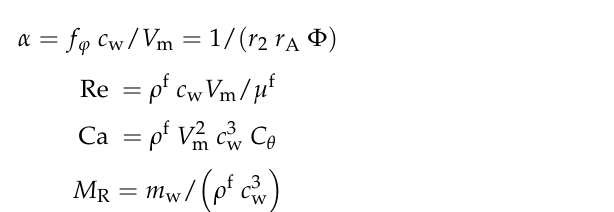
Figure 4. Concept of the lumped torsional flexibility model.